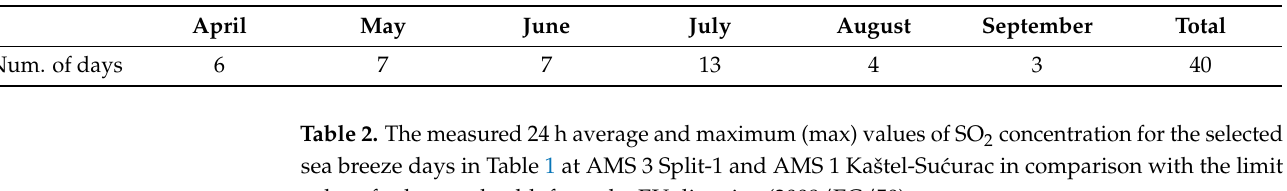
Table 1. Number of days with undisturbed coastal circulation for the period 2007–2009 at the Split-1 station.